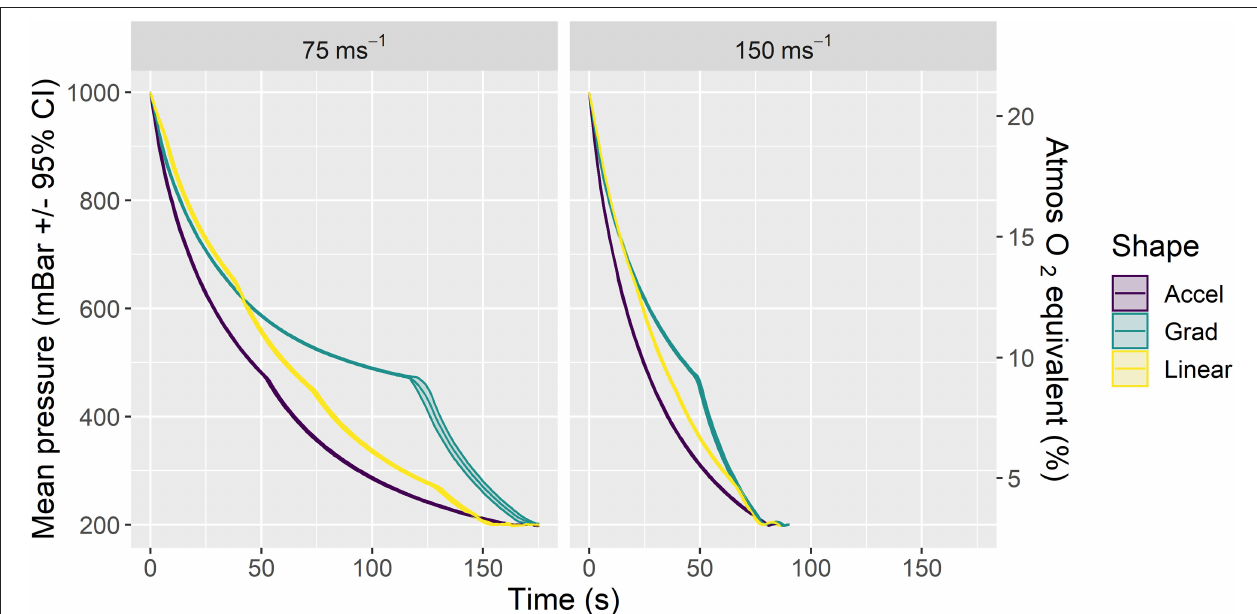
FIGURE 1 | Mean ± 95% CIs pressure (mBar) for phase 1 of the six candidate decompression profiles assessed according to rate (left panel: 75 ms − 1 , right panel: 150 ms − 1 ) and shape (Accelerated (Accel), Gradual (Grad) and Linear). Each profile consisted of gradual decompression to the target pressure of 200 mBar ( ∼ 11,800m equivalent altitude) in ∼ 157s (75 ms − 1 rate) or 79s (150 ms − 1 rate) for all shapes. Once target pressure was reached, a subsequent minimum hold phase for 5min (phase 2) was initiated and extended in additional 1-min increments until death confirmation (i.e., > 30s of motionless) as necessary. The chamber was then recompressed (phase 2 and recompression not displayed in figure, details in Table 2 ). The secondary y axis (right) is a scaled indication of comparable atmospheric O